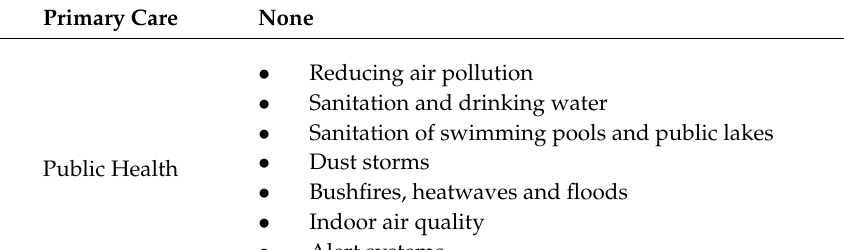
Table 4. Division of environmental health services.